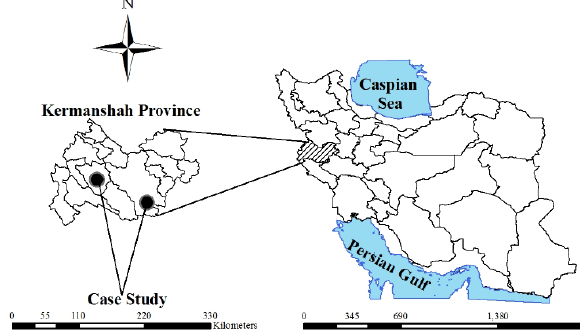
Figure 1. The locations of two selected